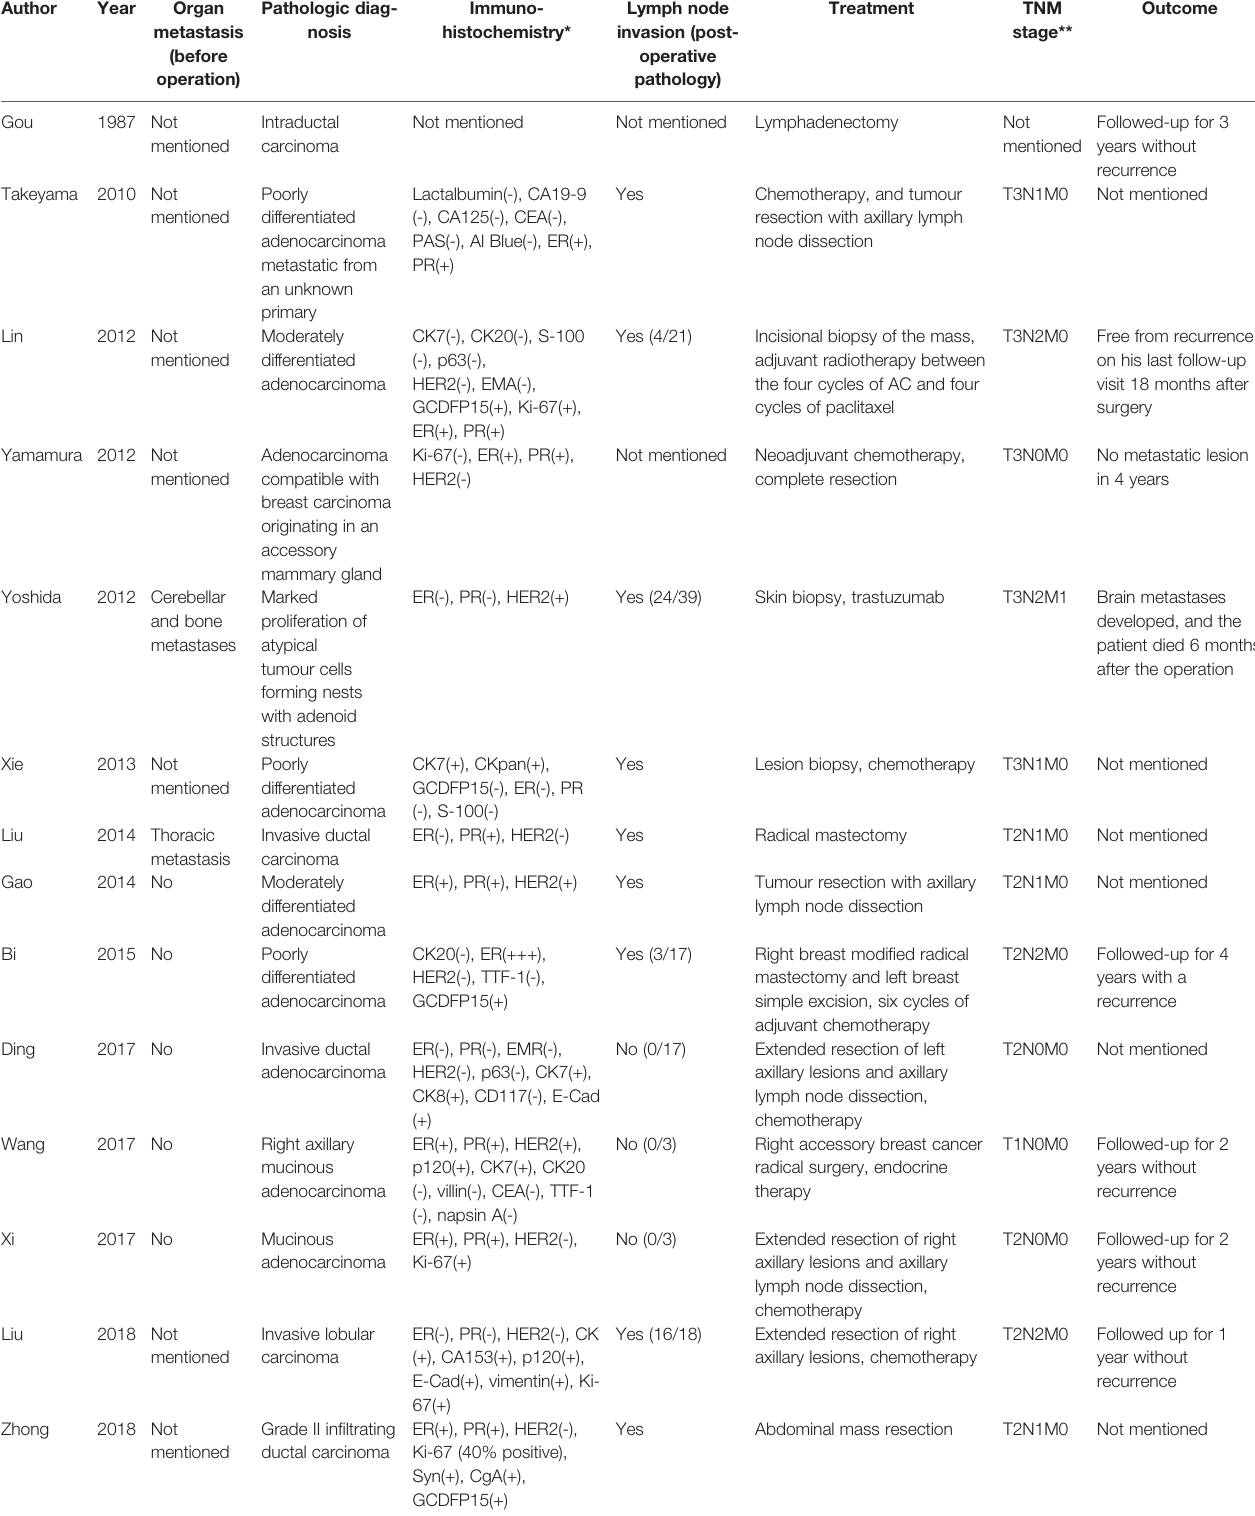
TABLE 2 | Pathology, treatment, and patient prognosis in the included